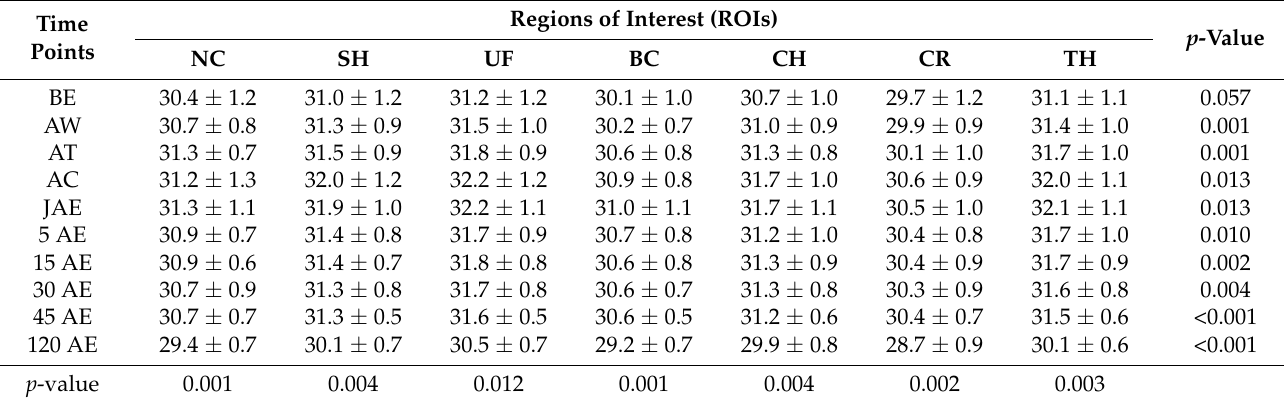
0.003 ANOVA indicated a significant effect of ROI on body surface temperature ( p < 0.001; F = 54.3). The value of the analysis of variance statistics (F = 54.3) and the corresponding significance level ( p < 0.001) indicate that the mean temperature of at least two regions differs significantly. The highest surface temperature was recorded in the UF region (31.6 ◦ C), and it was significantly higher than the temperatures in the NC, BC, CH, and CR regions. The temperature was similar in the TH (31.5 ◦ C) and SH (31.3 ◦ C) regions. The lowest body surface temperature was indicated in CR (30.1 ◦ C), and it was lower than all the other regions ( p < 0.001). Furthermore, the BC region presented the low body surface temperature (30.5 ◦ C), which did not differ significantly only from the NC region (30.7 ◦ C) (Figure 2). ANOVA F = 54.3, p < 0.001